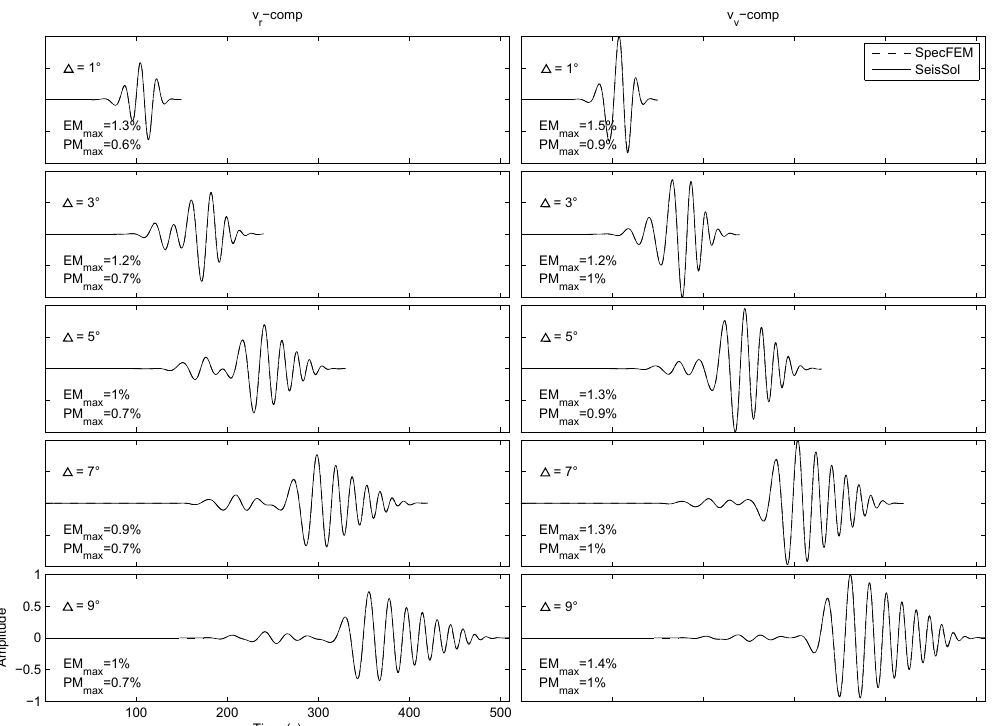
Fig. 2. Synthetic seismograms obtained on the 1-D isotropic PREM model by the ADER-DG (solid) and spectral-element method (dashed) compared at epicentral distances 1 for an explosive source located at the North Pole. The data are convolved with a Ricker source time function and filtered to periods of T ≥ 20s. Amplitudes of the radial v r and vertical v v velocity component are normalized with respect to v v . The fit between the different synthetic results is quantified by the phase (PM) and envelope (EM) time-frequency misfits. Artificial boundary reflections are